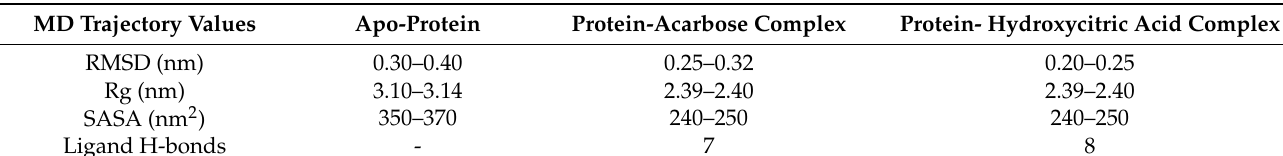
Table 11. MD values of hydroxycitric acid and acarbose complexes along with α -glucosidase.